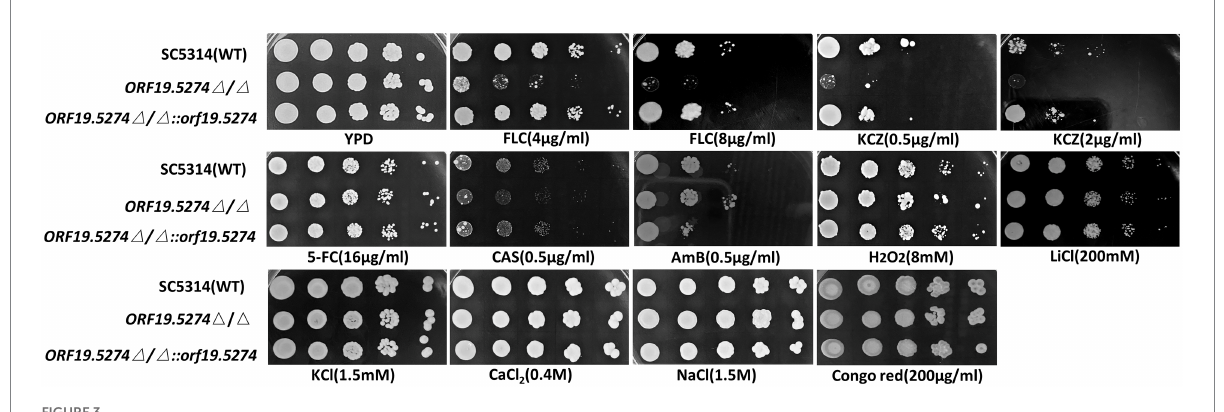
FIGURE 3 Spot assay to determine the sensitivity of Candida albicans to antifungal